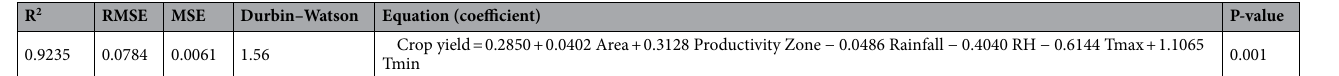
Table 3. Results of MLR analysis to estimate crop yield of cherry coffee productivity.